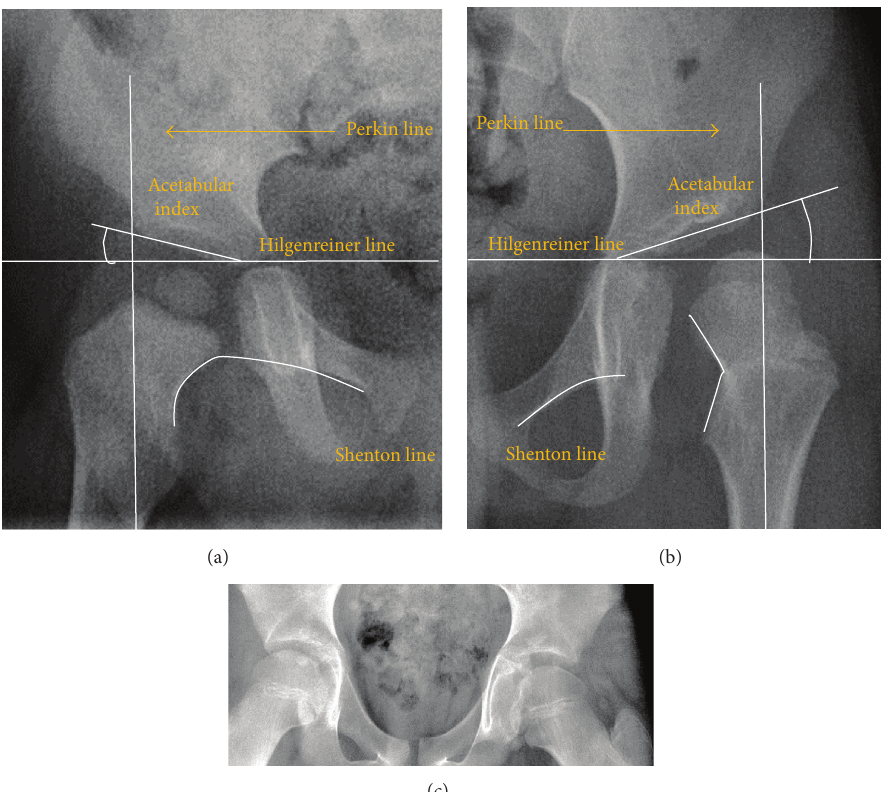
Figure 2: Radiological measurements in pediatric normal (a) and dysplastic hip (b). (c) AP view of a patient with left hip effusion secondary to trauma showing widening of the medial joint